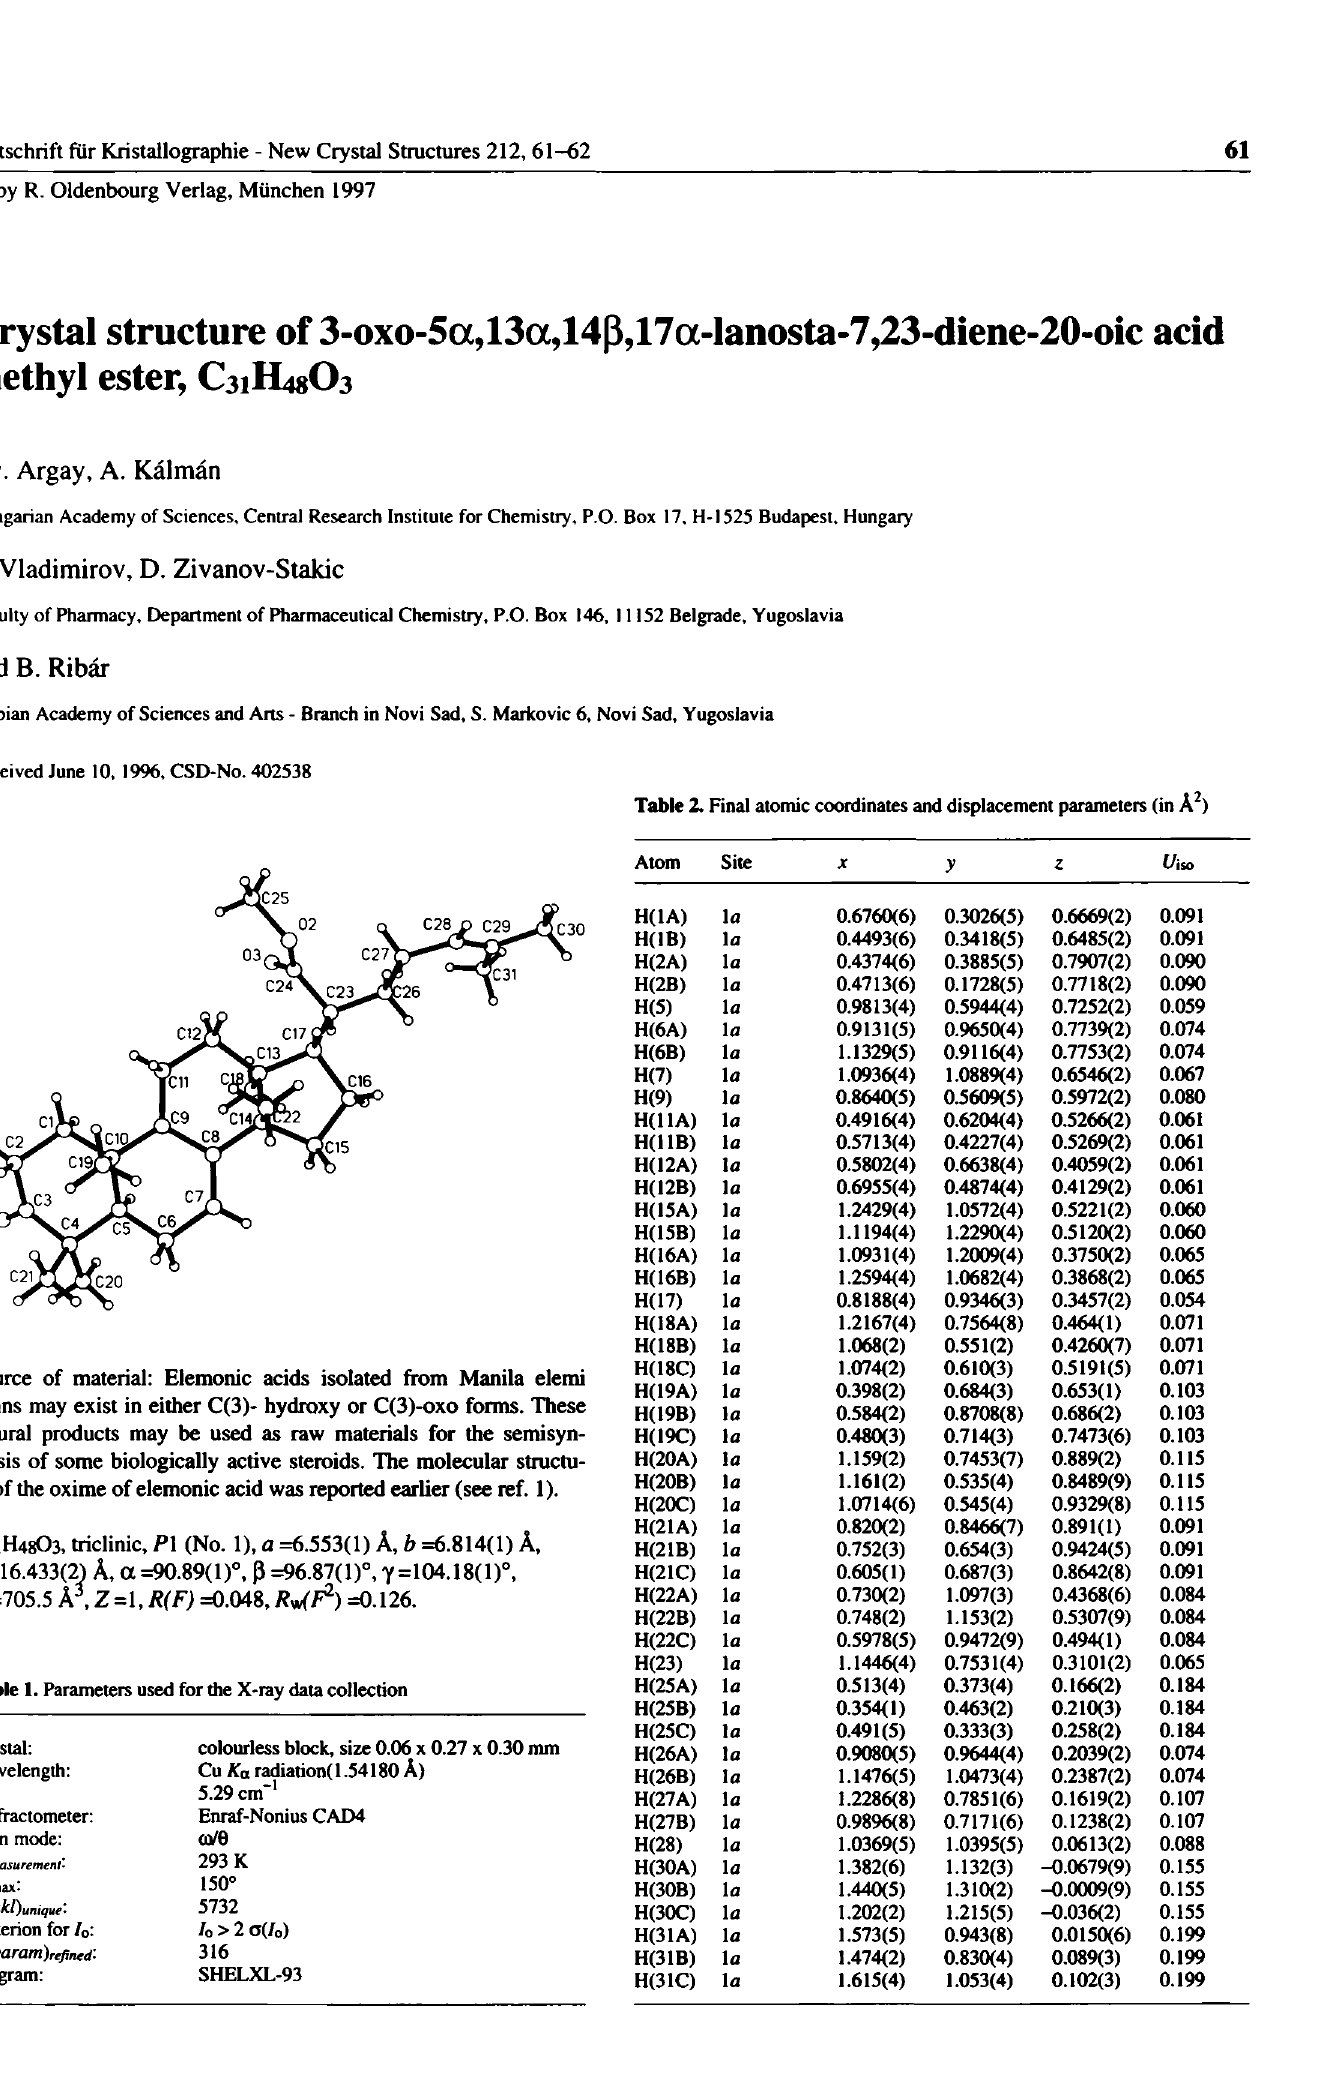
Table 2. Final atomic coordinates and displacement parameters (in A 2